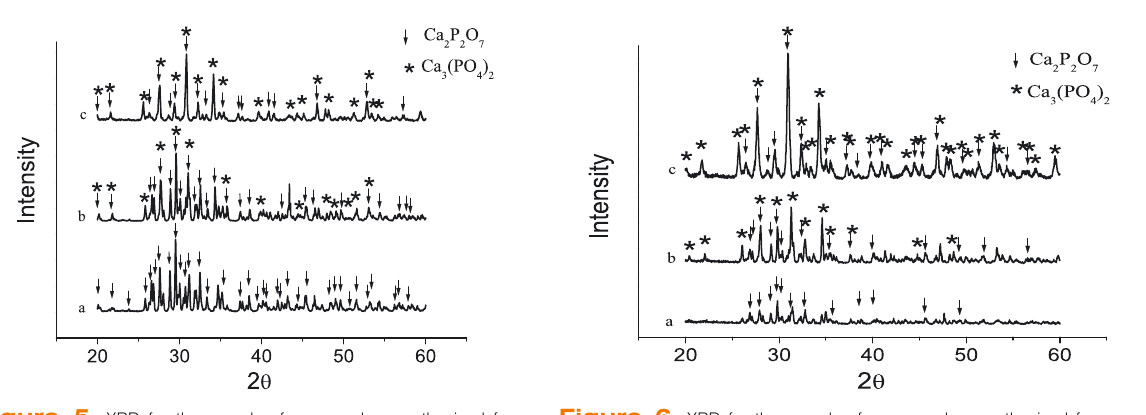
from (NH ) HPO and Ca(NO 4 2 4 Ca(CH COO) (c) after firing at 1000 o C. 3 2